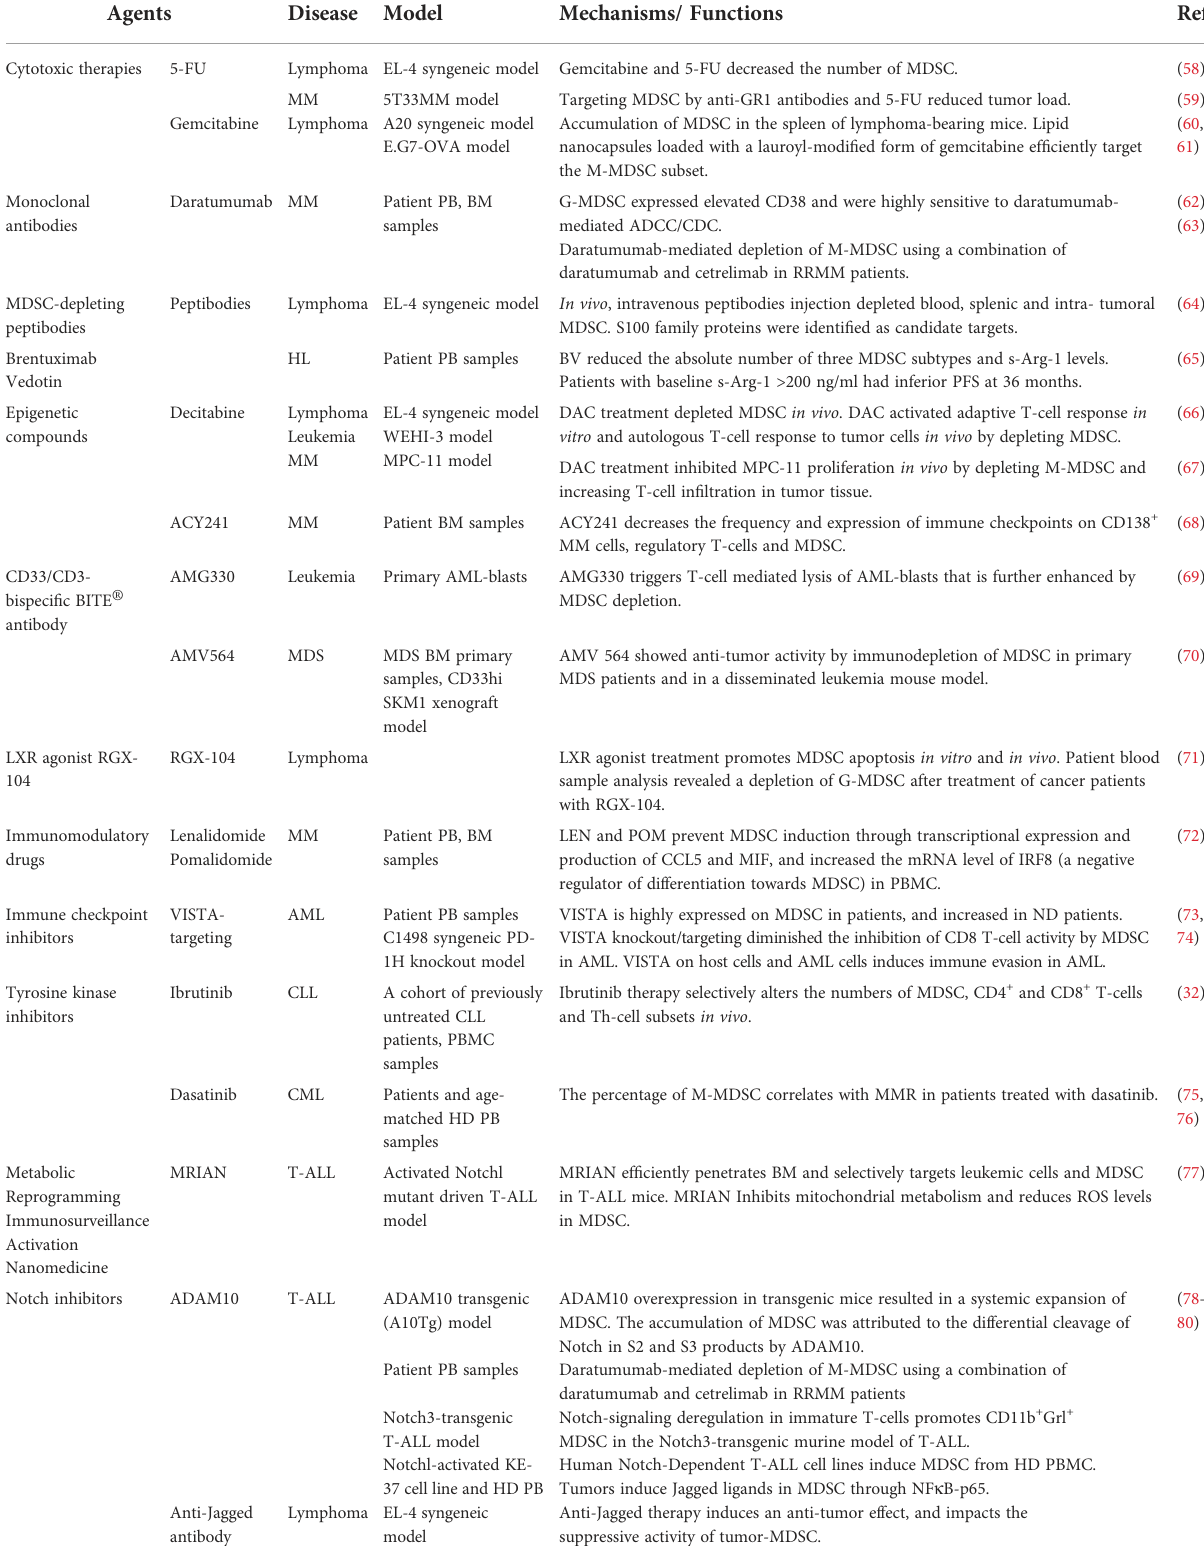
TABLE 2 Overview of MDSC-targeting approaches in hematological